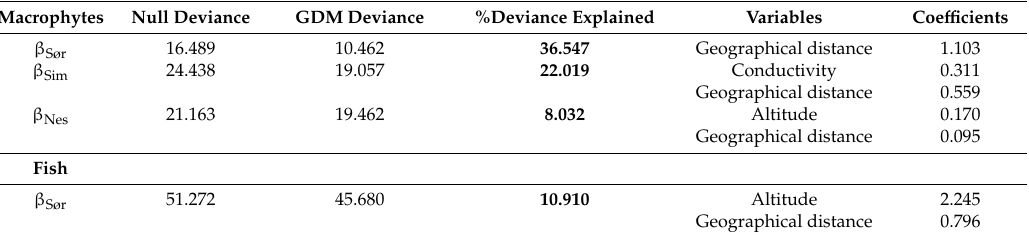
Table 4. Summary of the Generalized Dissimilarity Model (GDM), in which significant variables and their relative importance in the GDMs are presented (relative importance is determined by summing the coe ffi cients of the I-splines from GDM). The percentage of the total deviance explained by the fitted GDM and the null deviance are also presented.